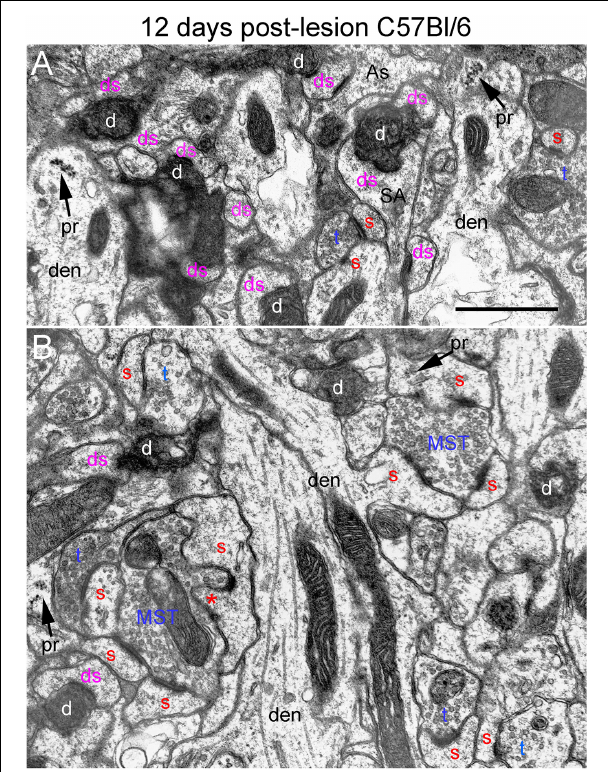
FIGURE 7 | Ultrastructure of synapses at 12 days post-lesion in C57Bl/6 mice. (A) Dark-dense terminal contacting multiple spine heads in C57Bl/6 mice. Arrows indicate empty PSDs (not contacted by either an intact or degenerating presynaptic terminal). Upper arrow indicates empty PSD apposed by astrocyte process. (B) Non-degenerating presynaptic terminal contacted multiple PSDs. Red s (red), spine head; t (blue), non-degenerating synaptic terminal; d (white) degenerating synaptic terminal; ds (purple) spine contacted by degenerating presynaptic terminal; den, dendrite; pr, polyribosomes. Calibration bar in (A) = 0.25 µ m and applies to (A,B) . *spinule.